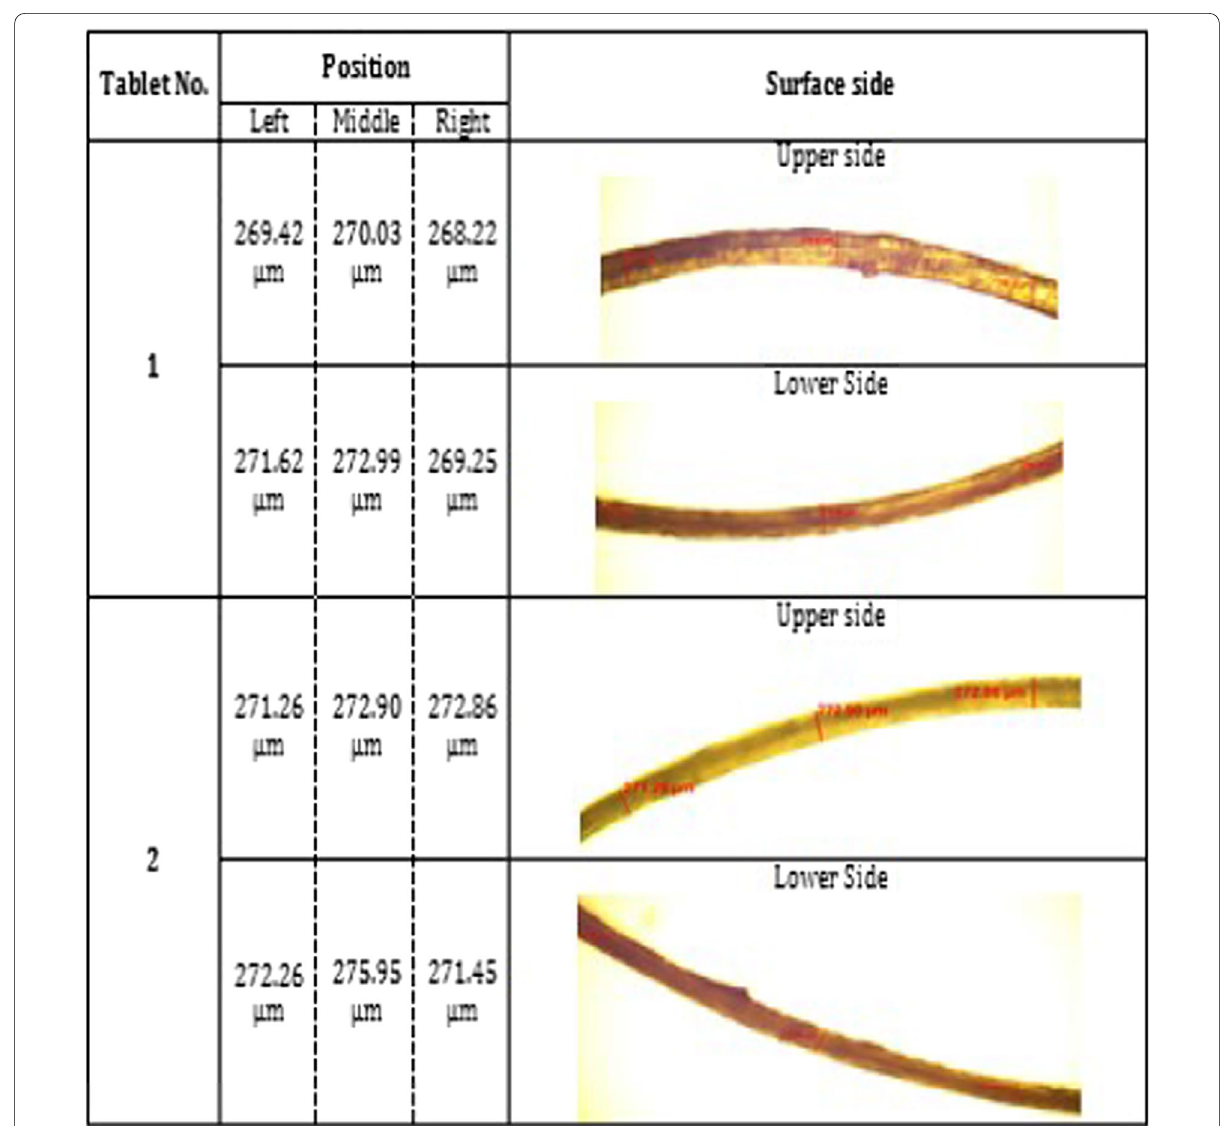
Fig. 7 Coating thickness of semipermeable membrane